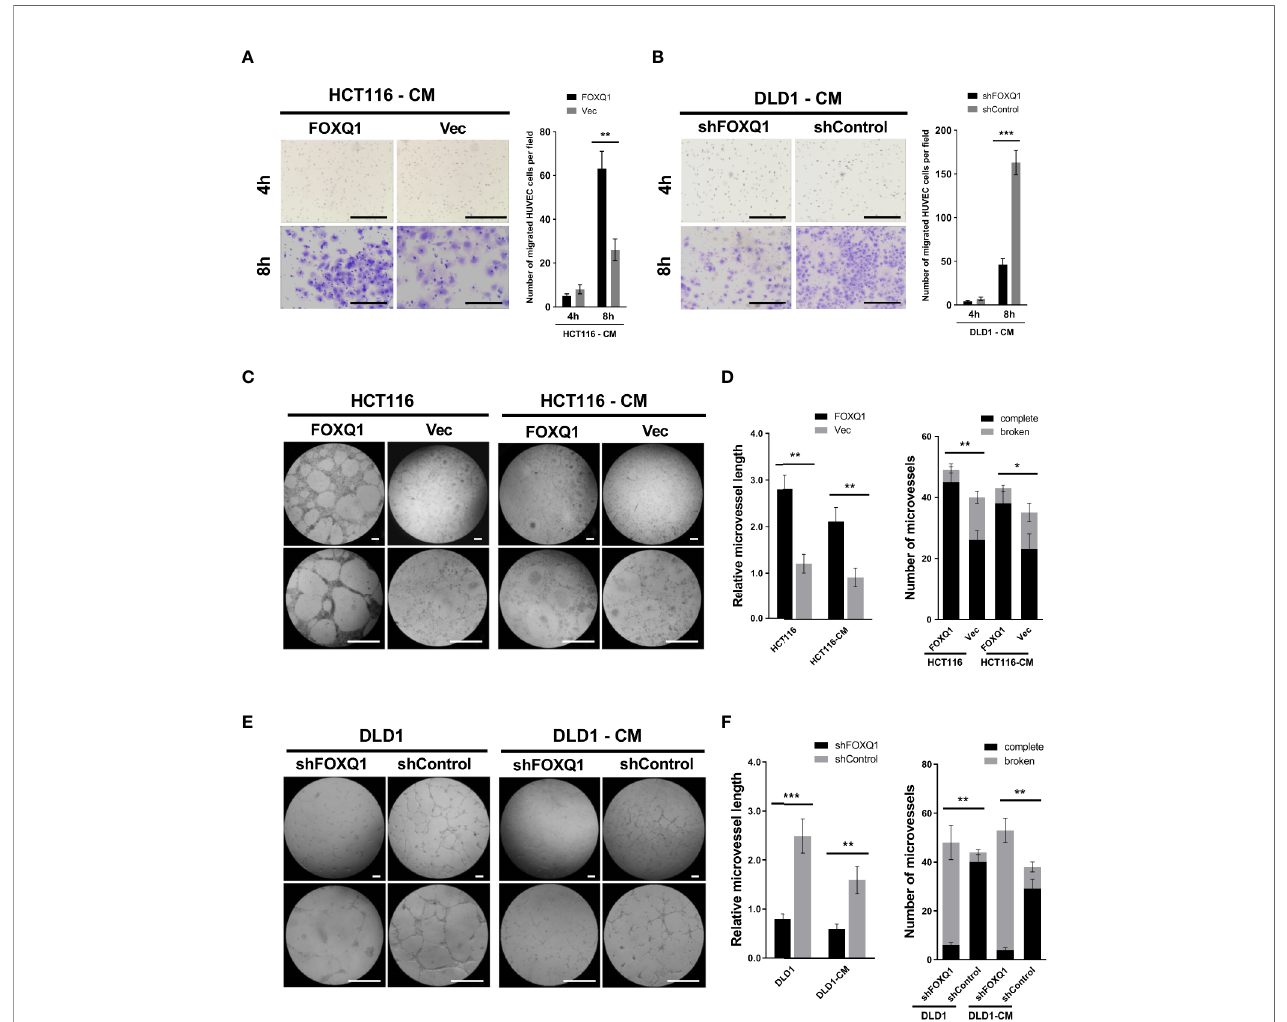
FIGURE 3 | FOXQ1 promotes colorectal cancer (CRC) angiogenesis by activating recruitment of HUVECs and promotes microvessel morphogenesis in vitro . HUVEC migration was imaged at 4 h and 8 h after cell seeding into the Transwells. The number of HUVECs that had migrated was counted and normalized to that of the control group. (A) Treatment of HUVECs with CM from HCT116-FOXQ1 displayed a higher ability to recruit HUVECs than those with CM from HCT116-Vec. (B) Conversely, blocking expression of FOXQ1 in DLD1-shFOXQ1 resulted in less recruitment of HUVECs than that in the control group at 8 h. (C) Representative images of microvessel formation for HUVECs either co-cultured with either HCT116-FOXQ1 or HCT116-Vec, or CM of either HCT116-FOXQ1 or HCT116-Vec. (D) The relative microvessel length and number of complete and broken microvessels in HCT116-FOXQ1 cultures was compared with that in HCT116-Vec cultures. FOXQ1 overexpression signi fi cantly increased both the relative microvessel length and number of complete microvessels in CRC. (E) Representative images of microvessel formation for HUVECs co-cultured with either DLD1-shFOXQ1 or DLD1-shControl, or CM of either DLD1-shFOXQ1 or DLD1-shControl. (F) The relative microvessel length and number of complete and broken microvessels in DLD1-shFOXQ1 was compared with that in DLD1-shControl. FOXQ1 knockdown signi fi cantly decreased both the relative microvessel length and the number of complete microvessels in CRC. All scale bars represent 100 m m. * P <0.05, ** P <0.01, *** P <0.001 signify a signi fi cant difference between the indicated groups (two-tailed, unpaired Student ’ s t -test). CM, conditioned